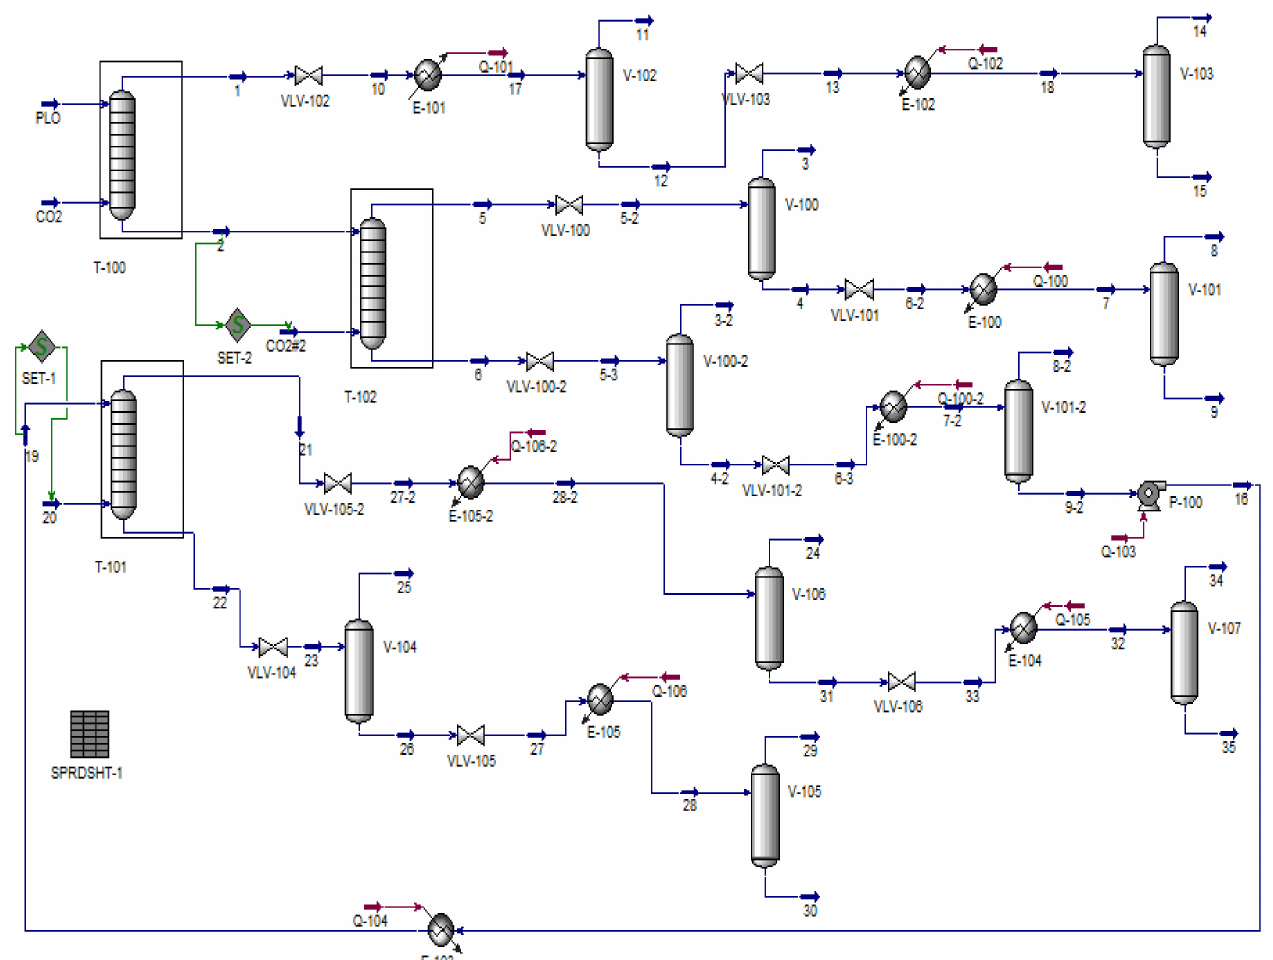
Figure 5. Process flowsheet (absorber columns (T-100, T-101, T-102), flash drums (V-100, V-100-2, V-101, V-101-2, V-102, V-103, V-104, V-105, V-106, V-107), valves (VLV-100, VLV-100-2, VLV-101, VLV- 101-2, VLV-102, VLV-103, VLV-104, VLV-105, VLV-105-2, VLV-106), heat exchanges (E-100, E-100-2, E-101, E-102, E-103, E-104, E-105, E-105-2), make-ups (SET-1, SET-2), high-pressure pump (P-100)) for OLP deoxygenation in multistage countercurrent absorber columns using CO 2 as a solvent (raffinate 1 + CO 2 as the feed for the top stream of absorber T-102, raffinate 2 as the feed for the top stream of absorber T-101, and a CO 2 make-up as the feed for the bottom stream of absorber T-102 and of absorber